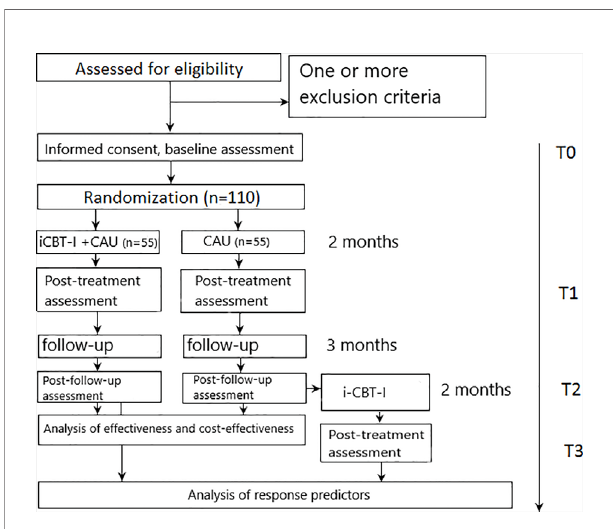
FIGURE 1 | Participants fl ow